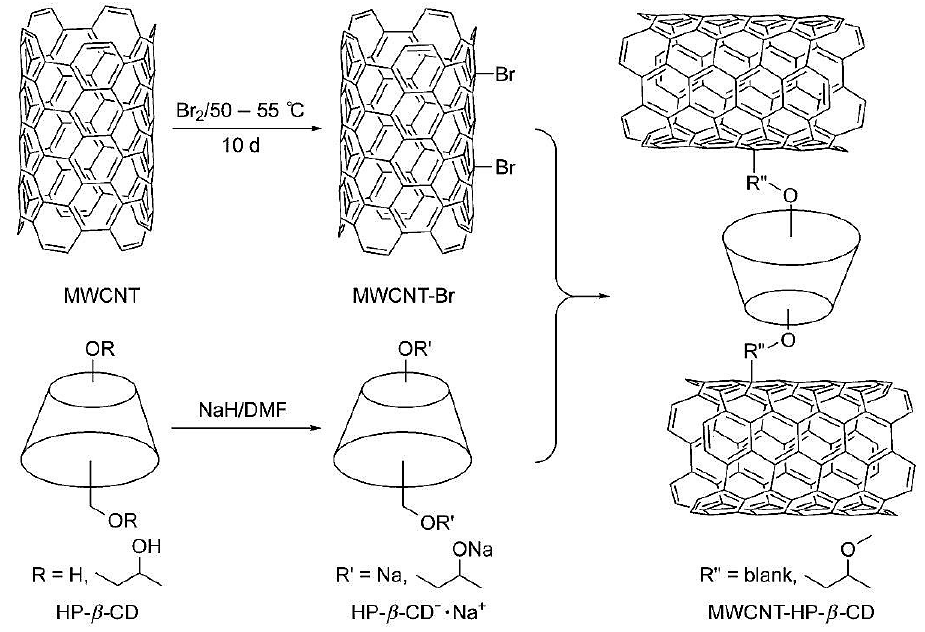
Figure 3. Schematic representation of the preparation of MWCNT-HP- β -CD “Reproduced with permission from Yu et al. [59]. Copyright Wiley, 2011”.